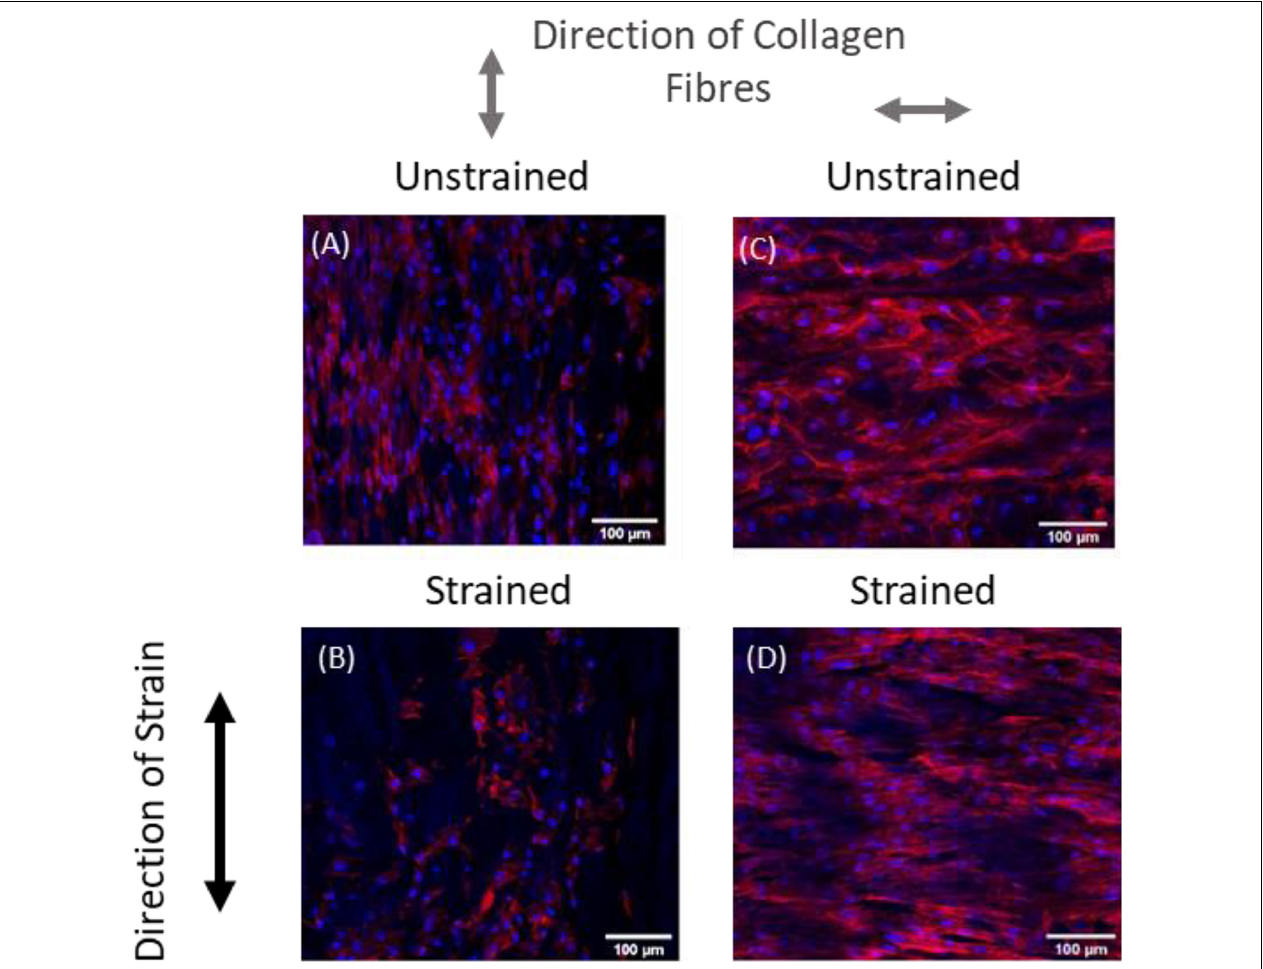
FIGURE 2 | Representative images of RASMC on decellularized porcine carotid artery samples (A–D) left unstrained, (A,C) or strained parallel (B) or perpendicular (D) to the direction of collagen fibers. Blue—Nuclei, Red—F-actin (Mathieu, 2020).